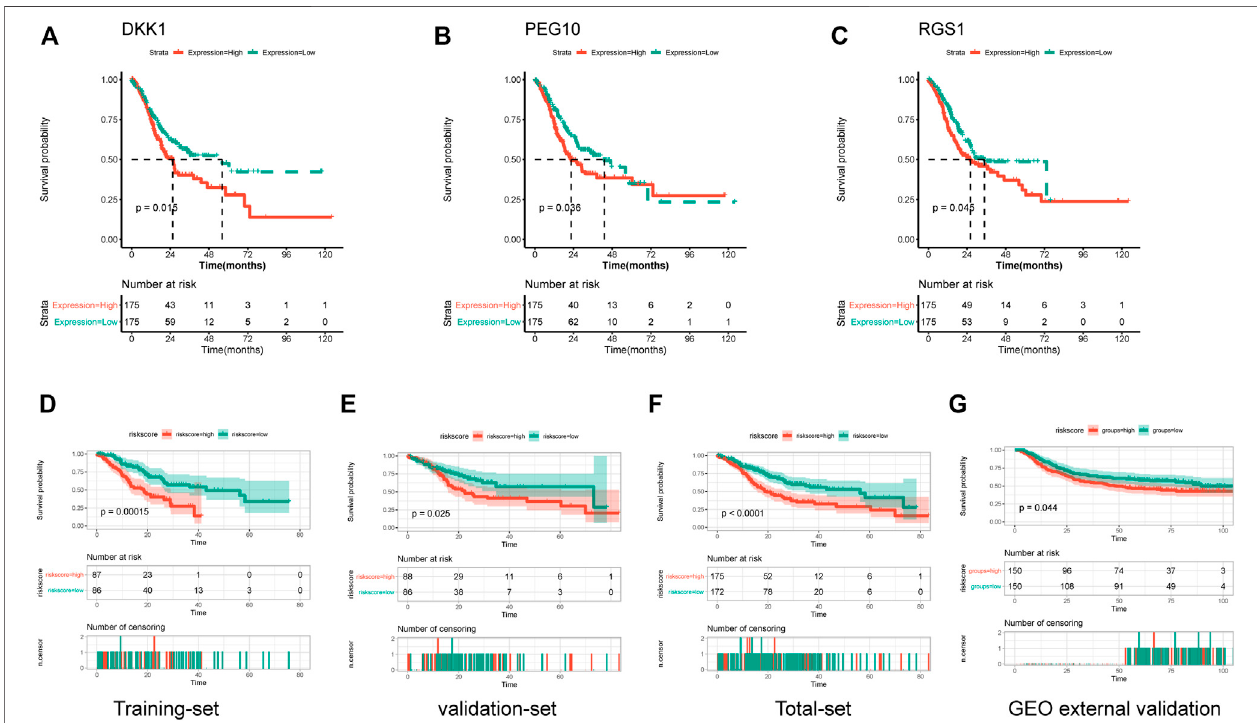
FIGURE 5 | Establishment and validation of prognostic risk model. (A – C) Kaplan-Meier curves showed the correlations of genes expression with overall survival. (D – G) Kaplan-Meier curves showed the correlations of risk score with overall survival in training-set, validation-set, total-set and GEO external validation set.